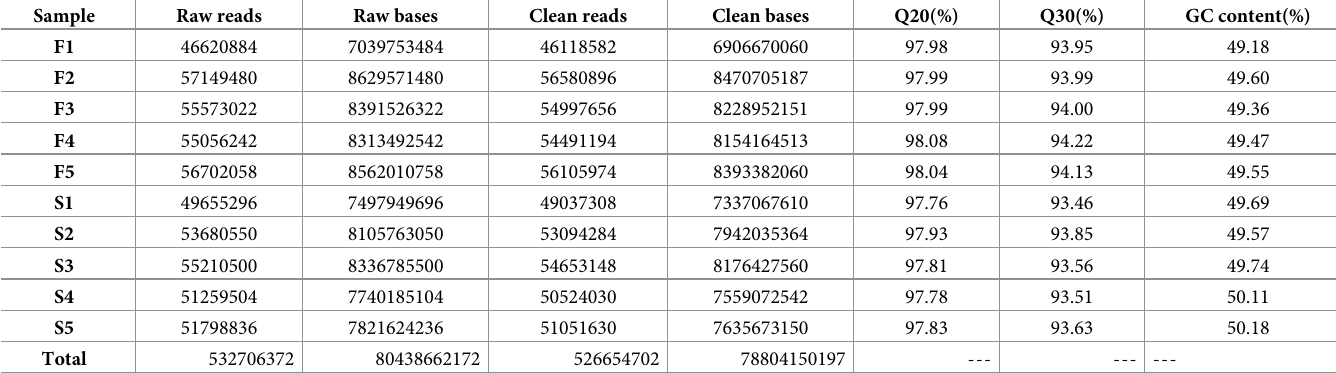
Table 2. Summary of sequences